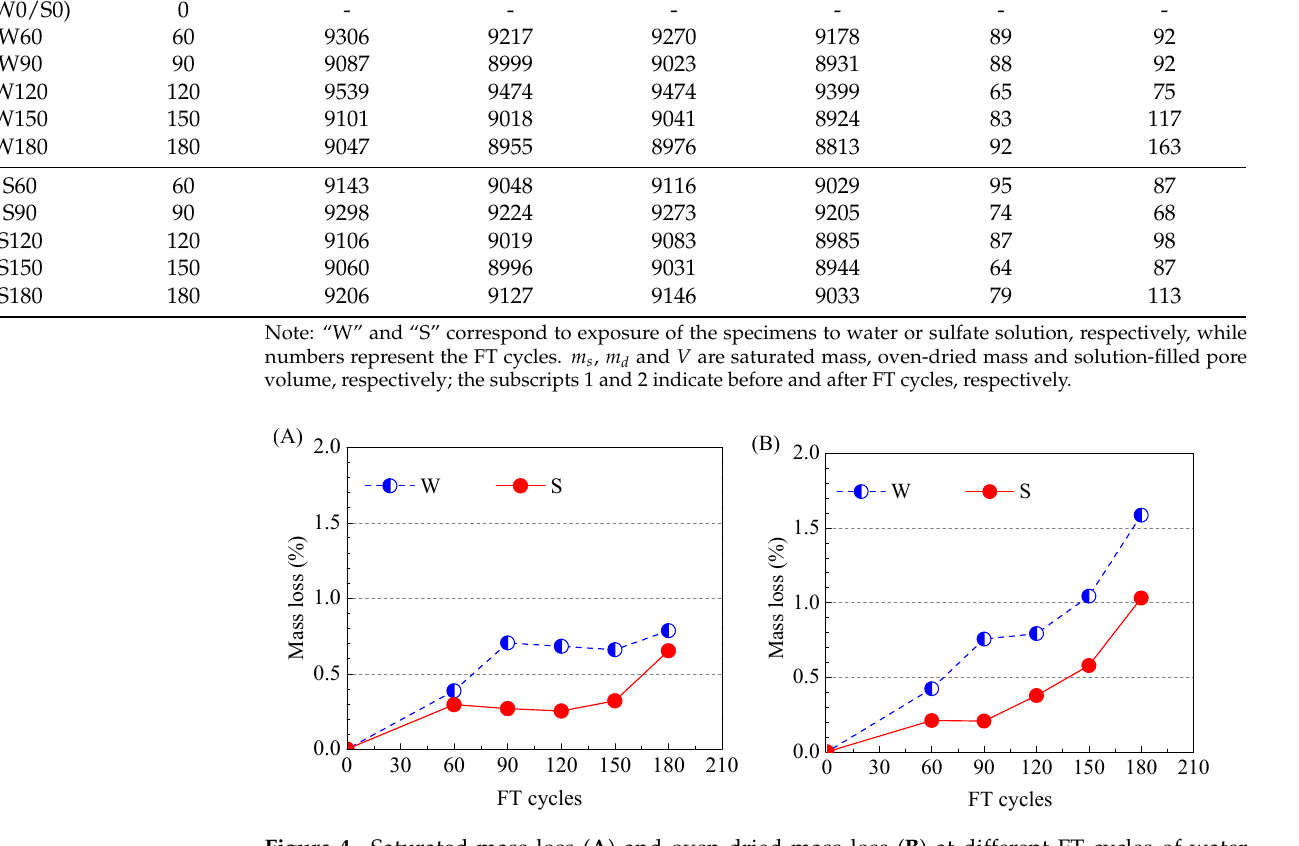
Figure 4. Saturated mass loss ( A ) and oven-dried mass loss ( B ) at different FT cycles of water saturated (W) and sulfate attack (S) RAC. saturated (W) and sulfate attack (S)